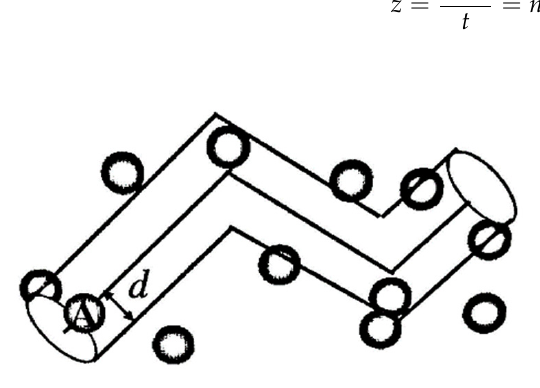
Figure 1. Diagram of the incident molecular motion.